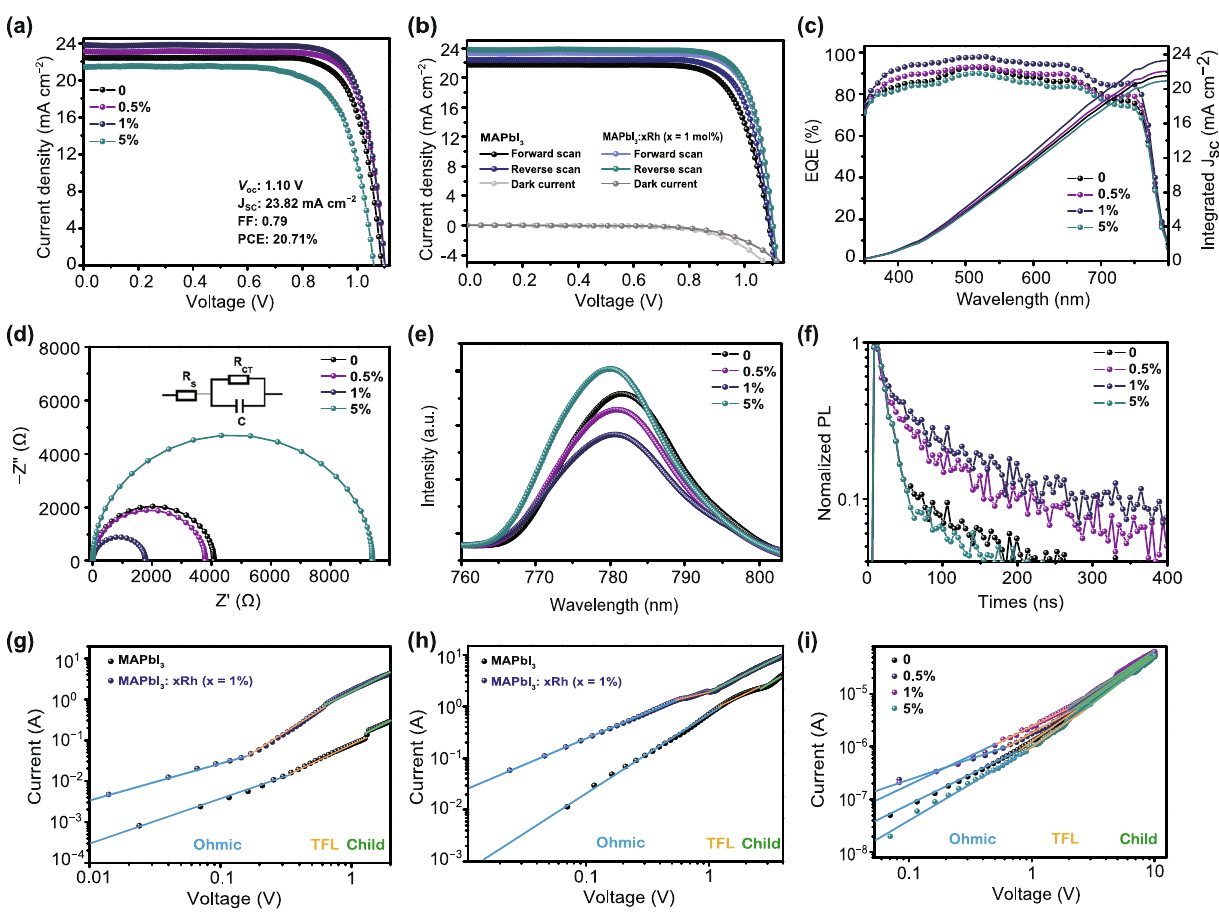
Fig. 4 a J – V , c EQE data and d Nyquist plots of PSCs fabricated by MAPbI 3 : x Rh (where x = 0, 0.5%, 1% and 5%). b Forward and reverse direc‑ tion J – V of PSC fabricated by MAPbI 3 : x Rh (where x = 0, 1%). e PL spectra of the MAPbI 3 : x Rh/SnO 2 films. f Time‑resolved PL spectrum of perovskite films based on MAPbI 3 : x Rh (where x = 0, 0.5%, 1% and 5%). I – V characteristic of g hole‑only device, h electron‑only device prepared by MAPbI 3 and MAPbI 3 : x Rh ( x = 1%). i Perovskite‑only device fabricated by MAPbI 3 : x Rh (where x = 0, 0.5%, 1% and 5%)